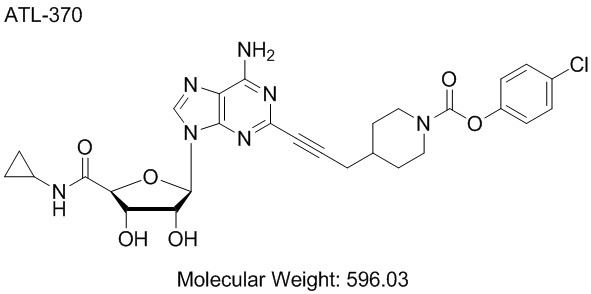
Molecular Structure and Weight of A2AAR Agonist, ATL370.